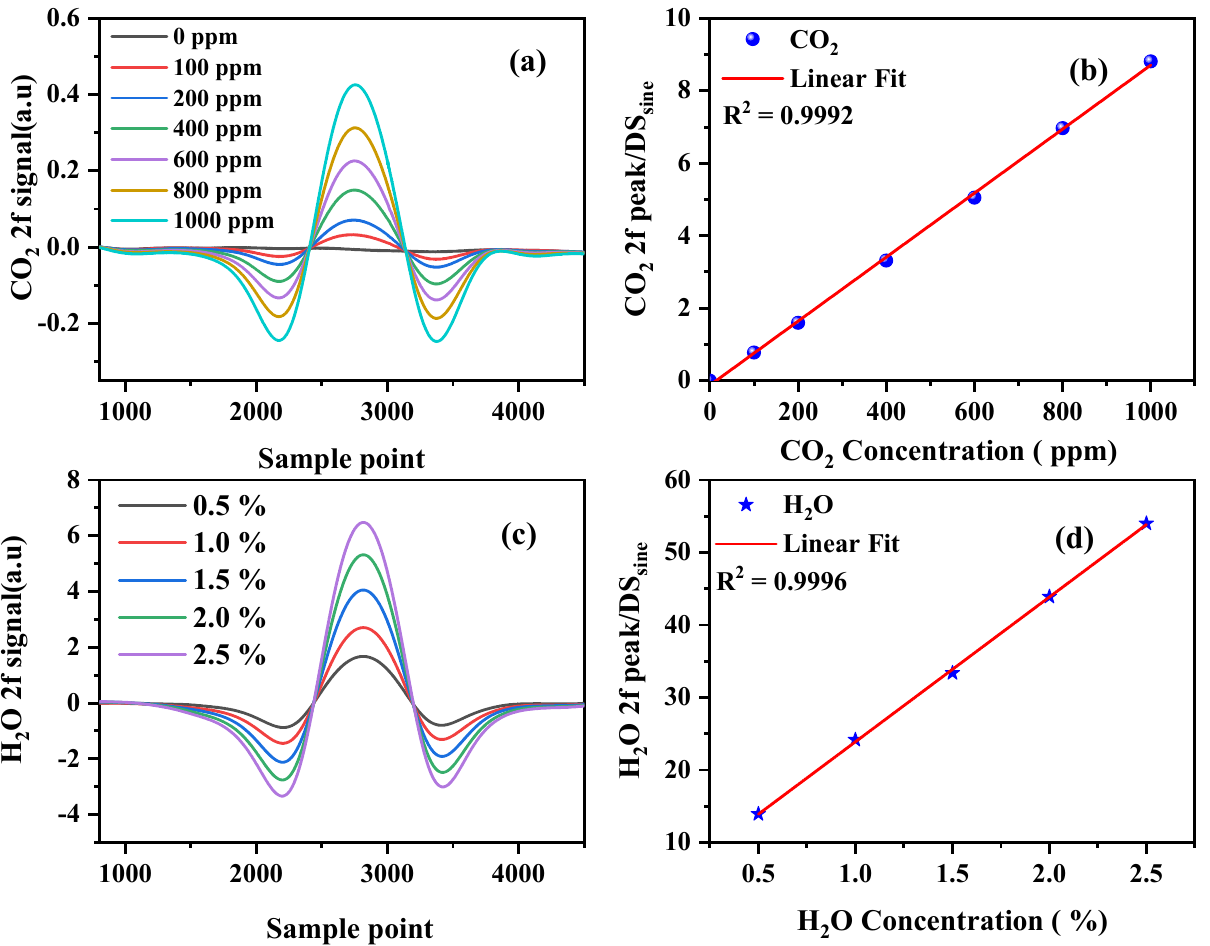
Figure 5. Second harmonic signal at different concentrations of ( a ) CO 2 and ( c ) H 2 O. Calibration measurements of the TDLAS system for ( b ) CO 2 and ( d ) H 2 O.